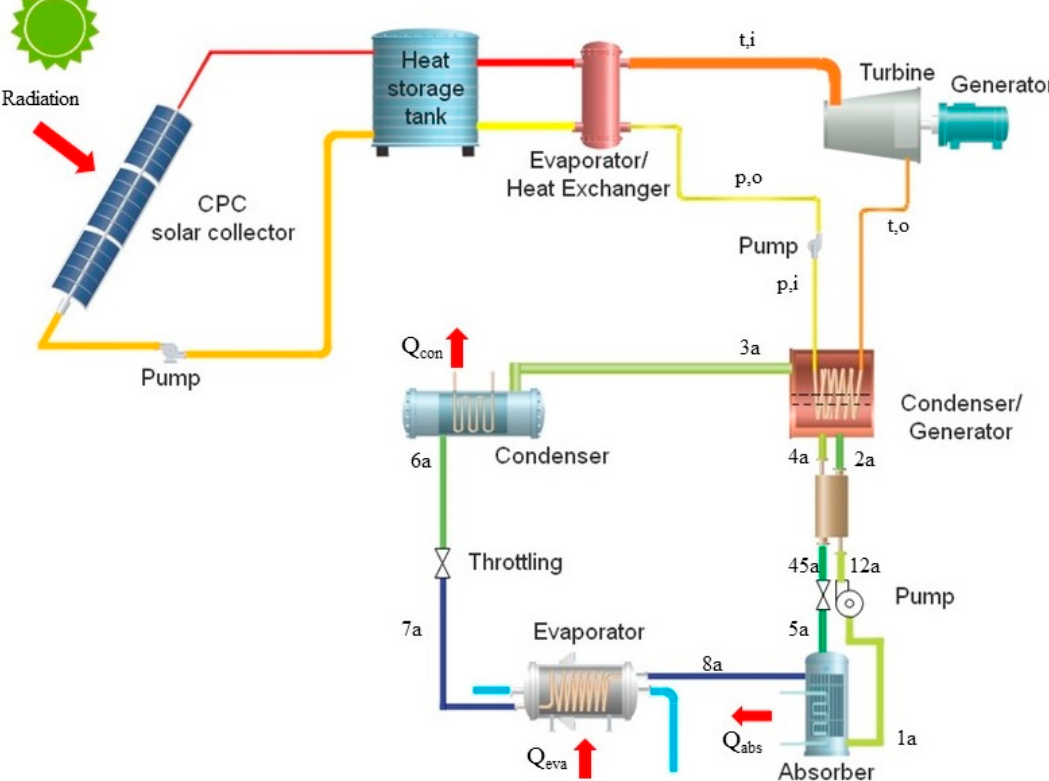
Figure 1. Schematic diagram of the cascade system (CS) for solar combined cooling, heating and power generation.